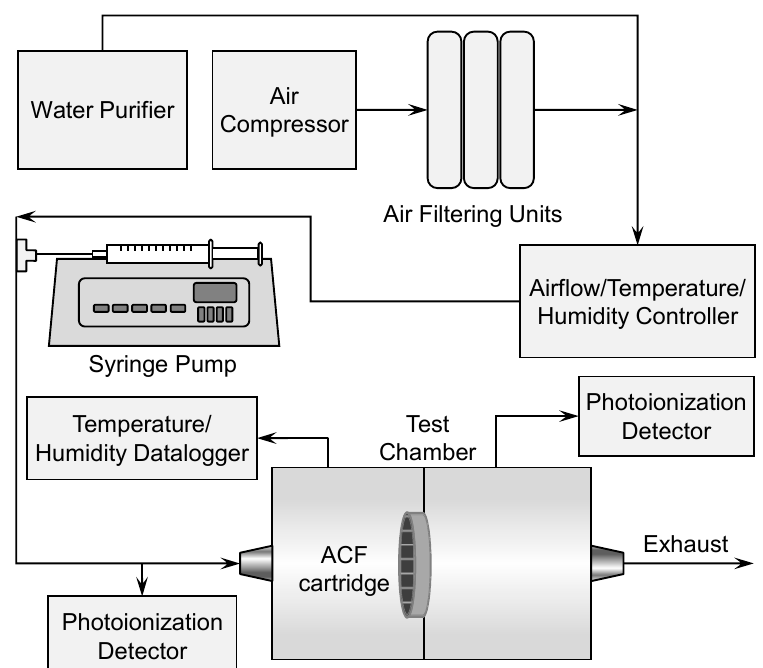
Figure 1. Experimental setup for breakthrough determination for toluene across an ACF respirator cartridge.